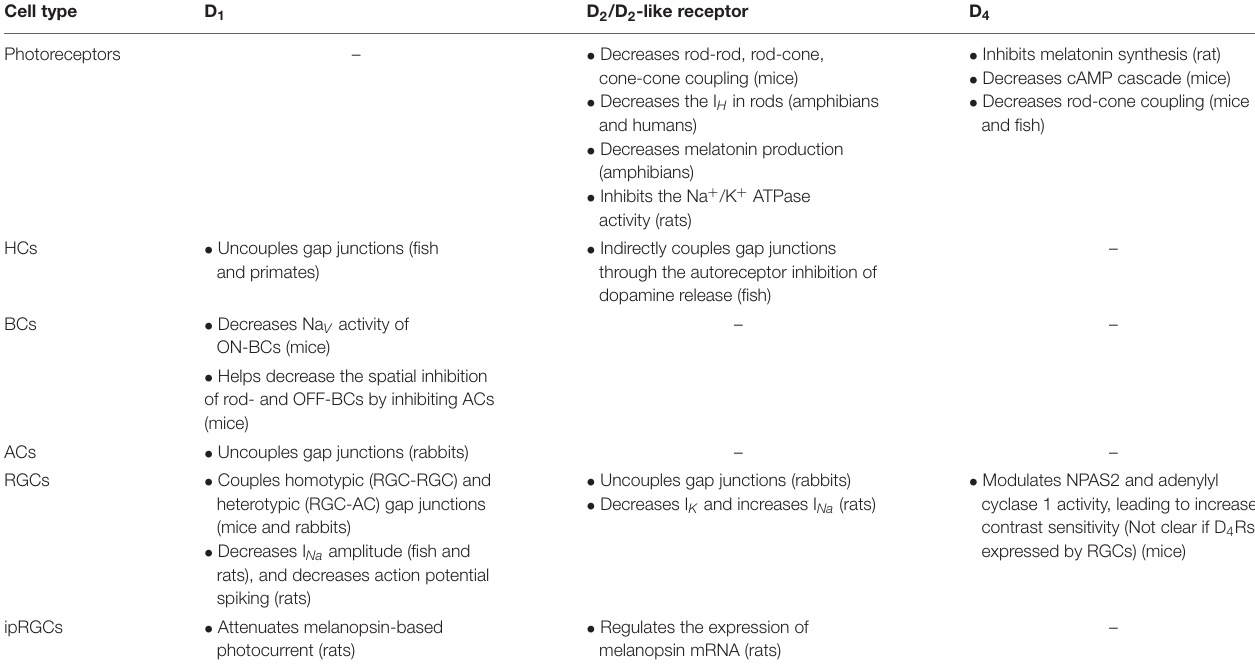
TABLE 1 | Neuromodulatory effects of dopamine receptors on retinal